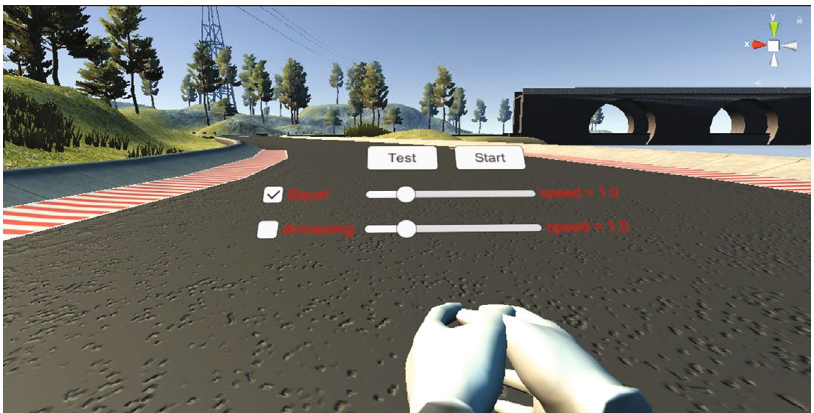
Figure 5: User interface of virtual running selection.